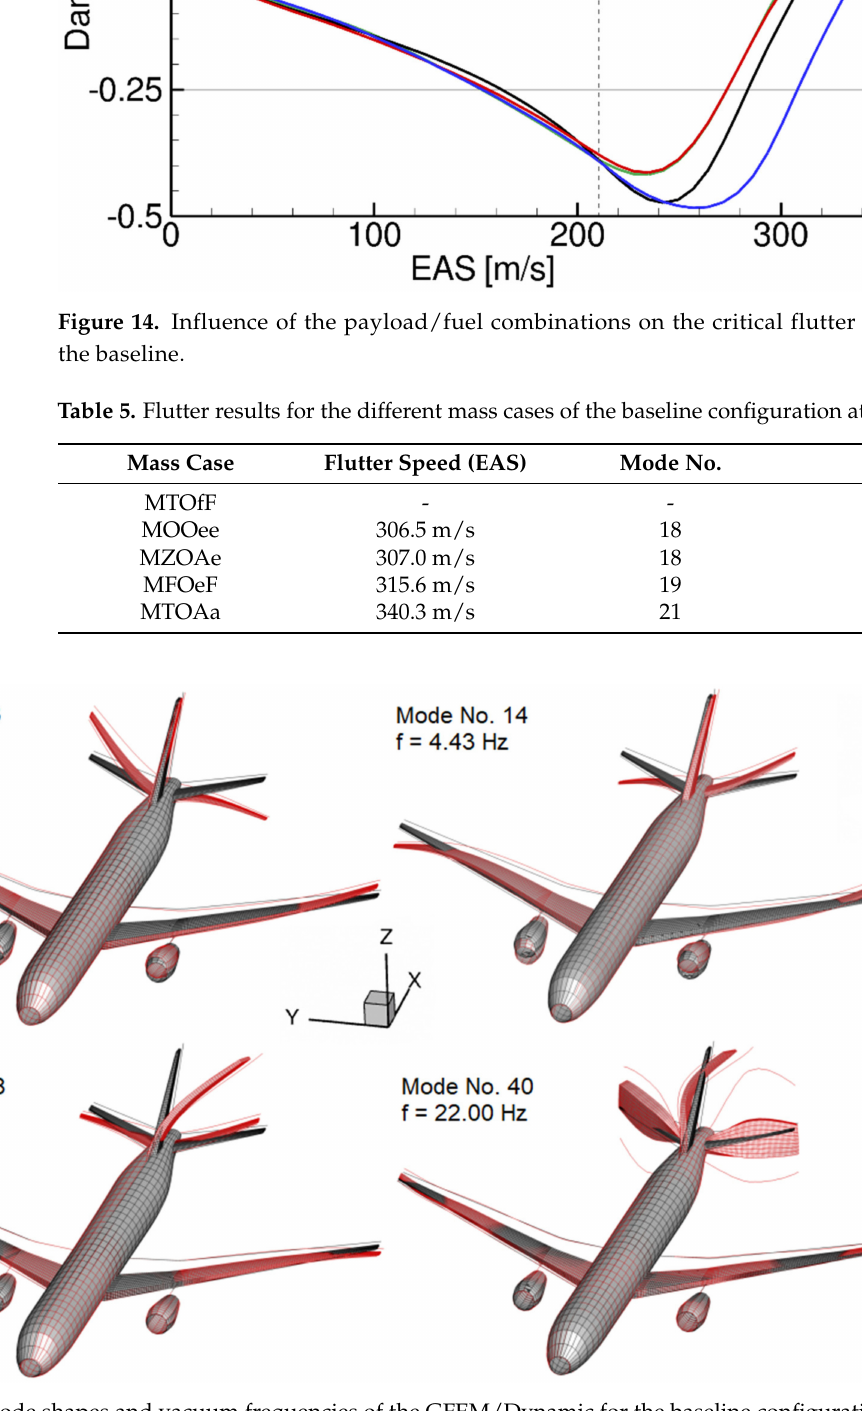
Figure 15. Mode shapes and vacuum frequencies of the GFEM/Dynamic for the baseline